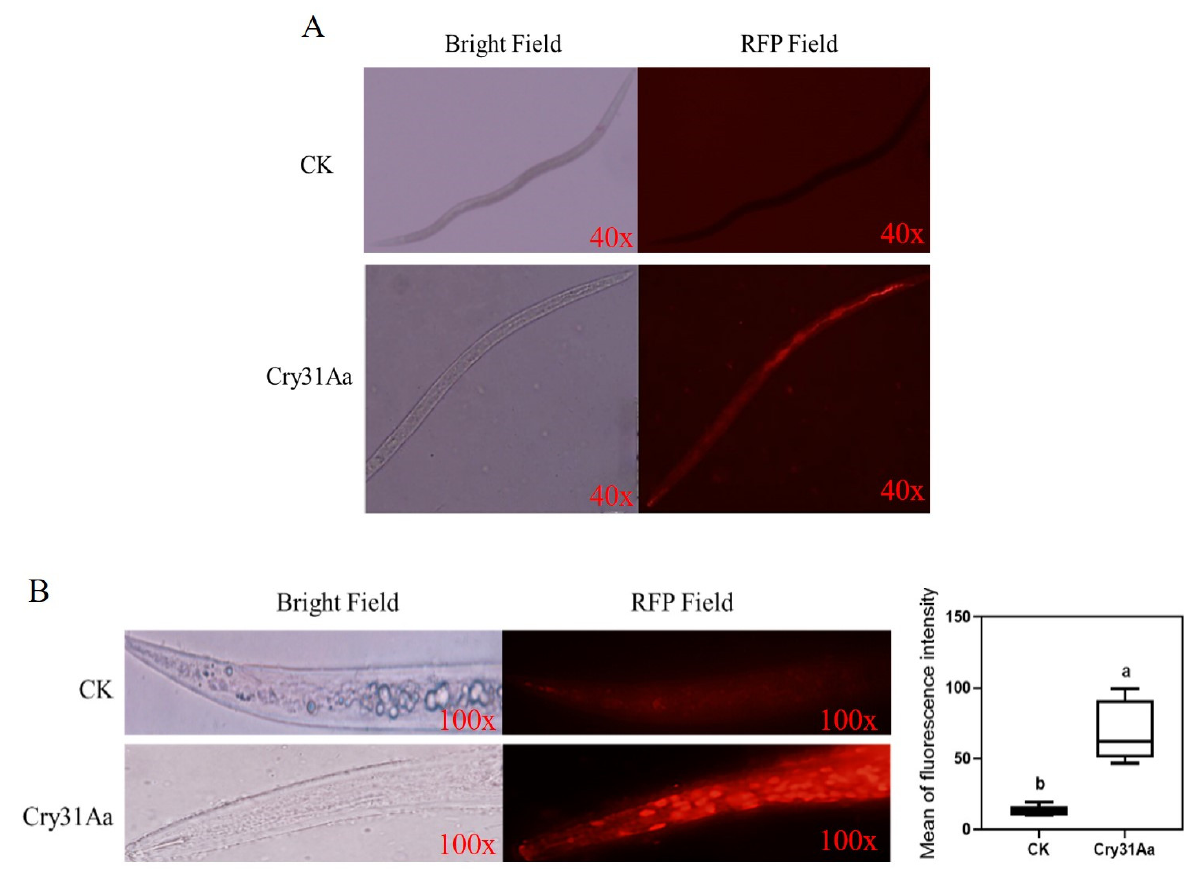
Figure 5. Observation of Cry proteins absorbed by A. besseyi : ( A ) the nematode A. besseyi after being treated with PBS as a control and rhodamine-labeled Cry31Aa were observed in bright and red fields; ( B ) the Cry31a protein produced the pore-formation toxin exposed to A. besseyi after staining with propidium iodide (PI), and fluorescence microscopy was used to monitor the signal of PI. The bright and red fields clearly indicate the changes in the intestinal cells. Different letters indicate significant differences at p < 0.005.